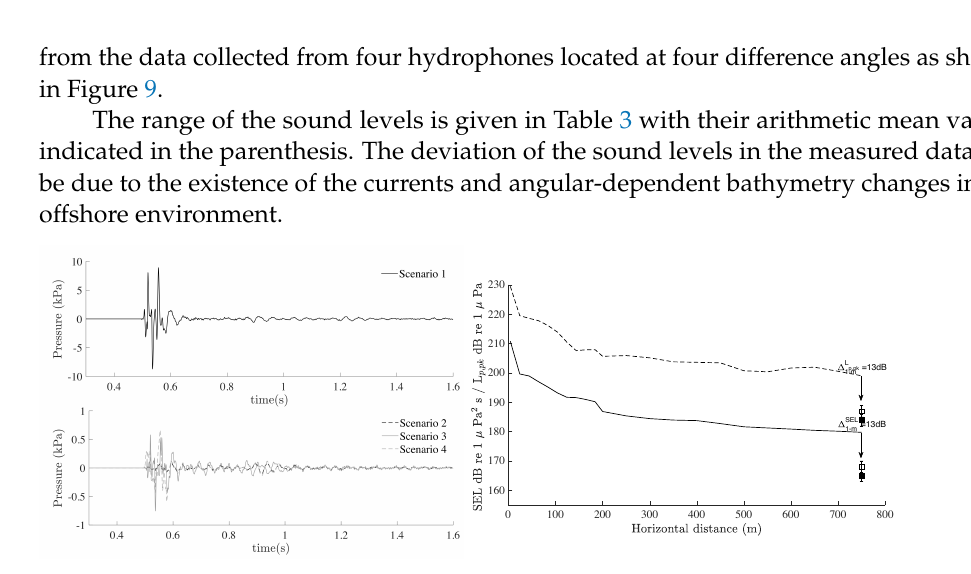
Figure 8. Prediction of the noise from the pile driving: ( left ) computed time histories of the pressure in the water at various radial distances at 2 m above the seabed, in which scenario 1 indicated by the black solid line; scenario 2 indicated by the black dashed line; scenario 3 indicated by the gray solid line; scenario 4 discussed in Section 6.2 indicated by the gray dashed line; and ( right ) comparison of SEL and L p , pk at 750 m radial distance from the pile and 2 m above the seabed with the comparison between the scenario 1 and arithmetic mean measured data.